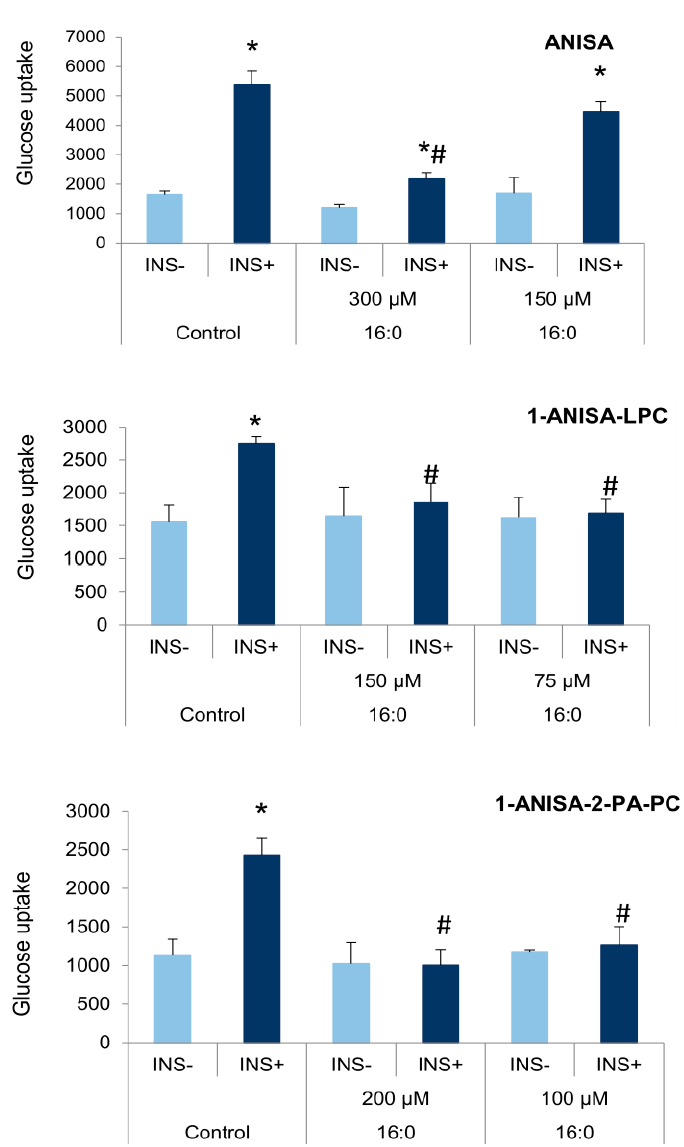
Figure 5. The insulin ‐ stimulated glucose uptake after insulin resistance induction in 3T3 ‐ L1 adi ‐ pocytes cultured with anisic acid and its derivatives. * statistical significance in relation to basal glucose uptake measured separately for each compound (INS − ); # statistical significance between insulin ‐ stimulated glucose uptake (INS+) in experimental and control cells; Student’s t ‐ test, p < 0.05.